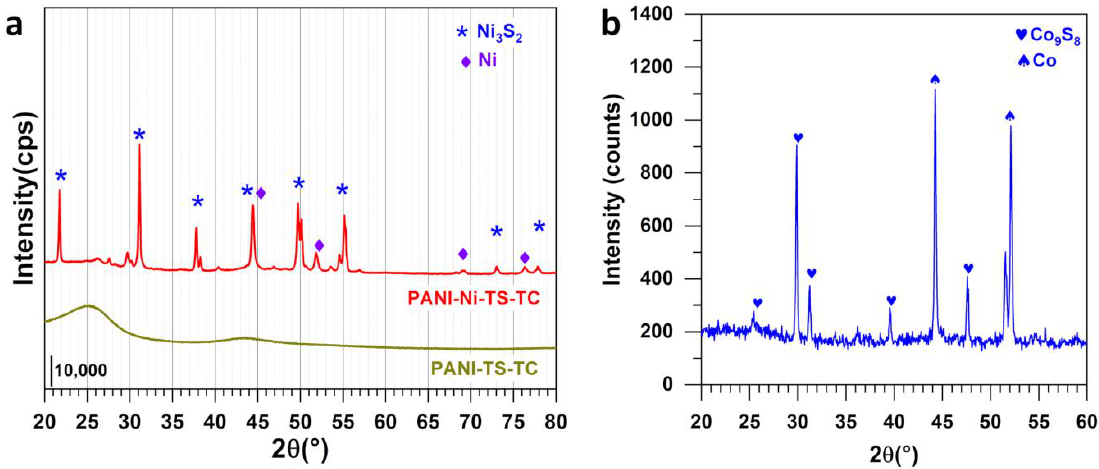
Figure 7. XRD patterns the electrocatalysts obtained after polymerization (5 °C, 13 h), stabilization (air, 350 °C, 2 h) and calcination (N 2 , 900 °C, 6 h): ( a ) PANI-TS-TC and PANI-Ni-TS-TC, and ( b ) PANI-Co-TS-TC.